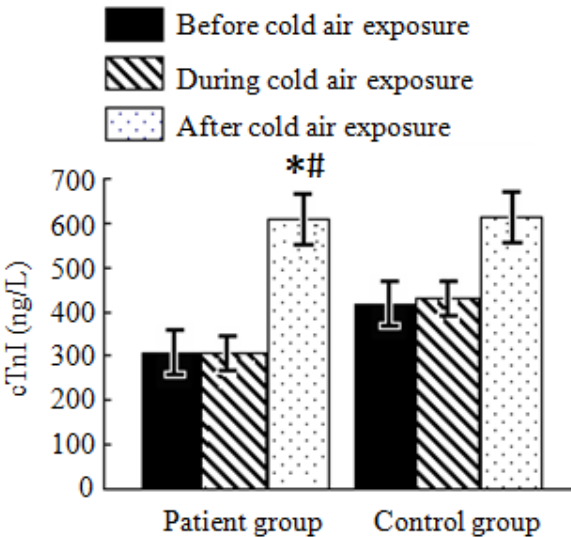
Figure 2. Average cTnI levels in the patient and control groups during a cold air